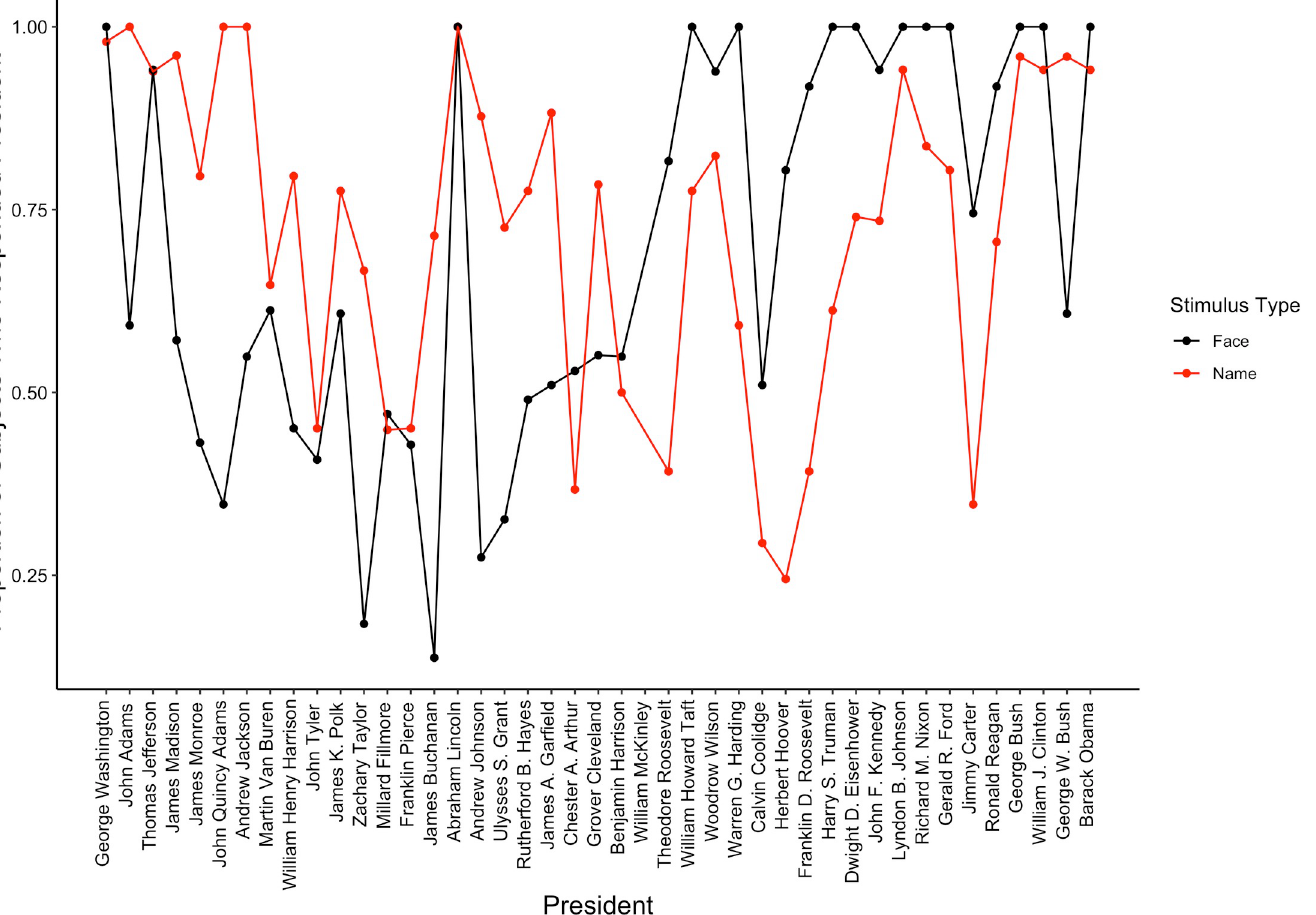
Fig 3. Proportion of subjects who responded “president” in response to seeing a president’s name or face.